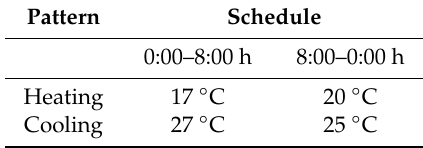
Table 3. Heating and Cooling patterns for the estimation of energy demand